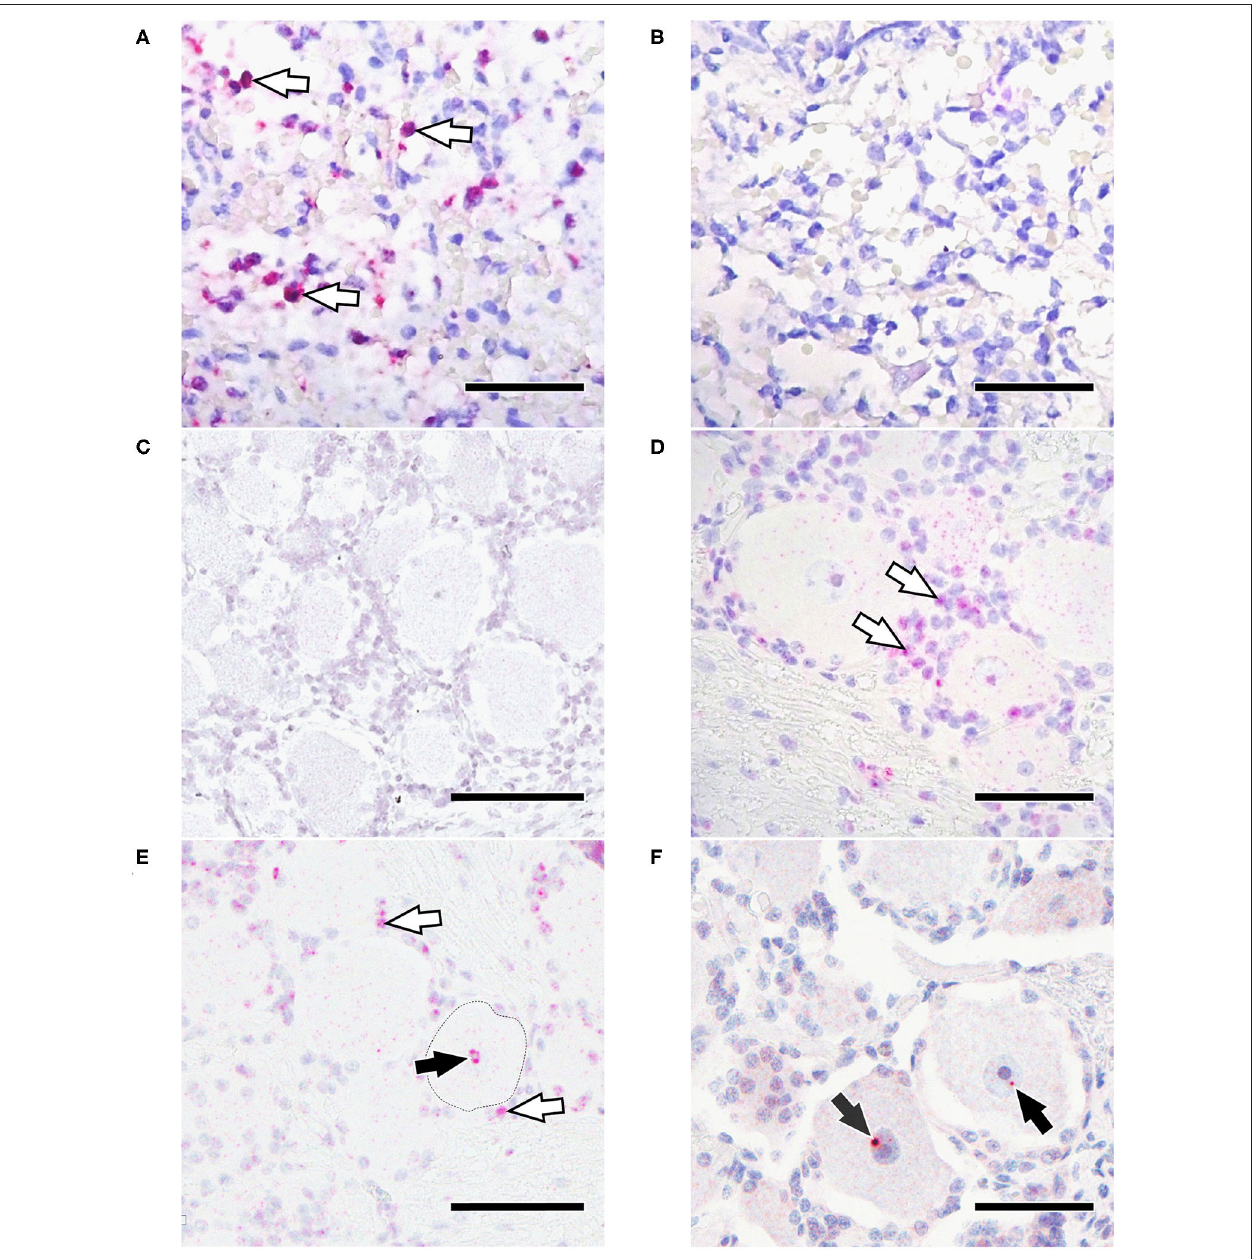
FIGURE 4 | In situ hybridization for EHV-1 gB. (A) Positive control with positive labeling (arrowheads); (B) Positive control tissue with no signal using an EHV-1 scrambled probe; (C) TG from a EHV-1 qPCR negative horse lacks positive ISH signal; (D) EHV-1 qPCR positive TG 30 dpi with strong signal in non-neuronal cells (arrowheads); (E) EHV-1 qPCR positive TG 30 dpi with strong in non-neuronal cells (white arrowheads) and nucleus of the neuron (black arrowhead); (F) EHV-1 positive TG 70 dpi with positive signal in the nucleus of the neuron (arrowhead). Bars = 50 µ m.